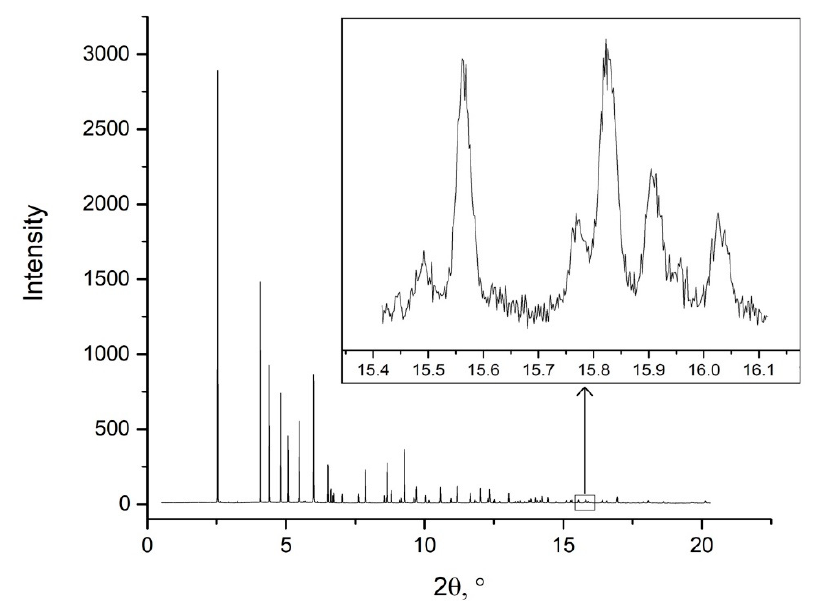
Figure 1. High-resolution synchrotron X-ray powder diffraction data ( λ = 0.354395 Å) of [NiEn 3 ](MoO 4 ) 0.5 (WO 4 ) 0.5 . The inserted diagram shows the splitting of lines at the far angles’ of diffraction. Table 1. Results of the study of [Ni En 3 ](MoO 4 ) 1 − x (WO 4 ) x individual single crystals *.